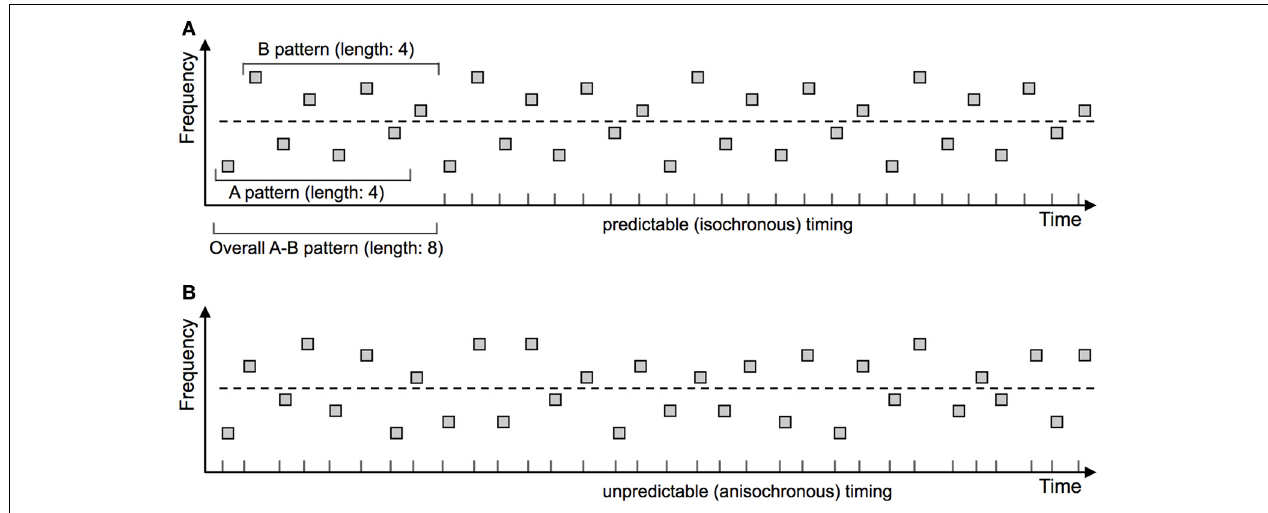
FIGURE 1 | Experimental paradigm confounding predictability of the “Integrated” and “Segregated” perceptual organizations. French-St. George and Bregman (1989) compared stimulus arrangements that were predictable or unpredictable with respect to stimulus timing and frequency. Sequences were predictable on both dimensions (A) , on neither dimension (B) , or on just one of the dimensions (not depicted). The cyclically repeating (thereby predictable) frequency patterns are marked in the upper panel. Stimulus timing is additionally marked by corresponding ticks on the X axis. The dashed line indicates the (nominal) separation between the “A” and “B” groups of tones. Participants were asked to try perceiving all tones as